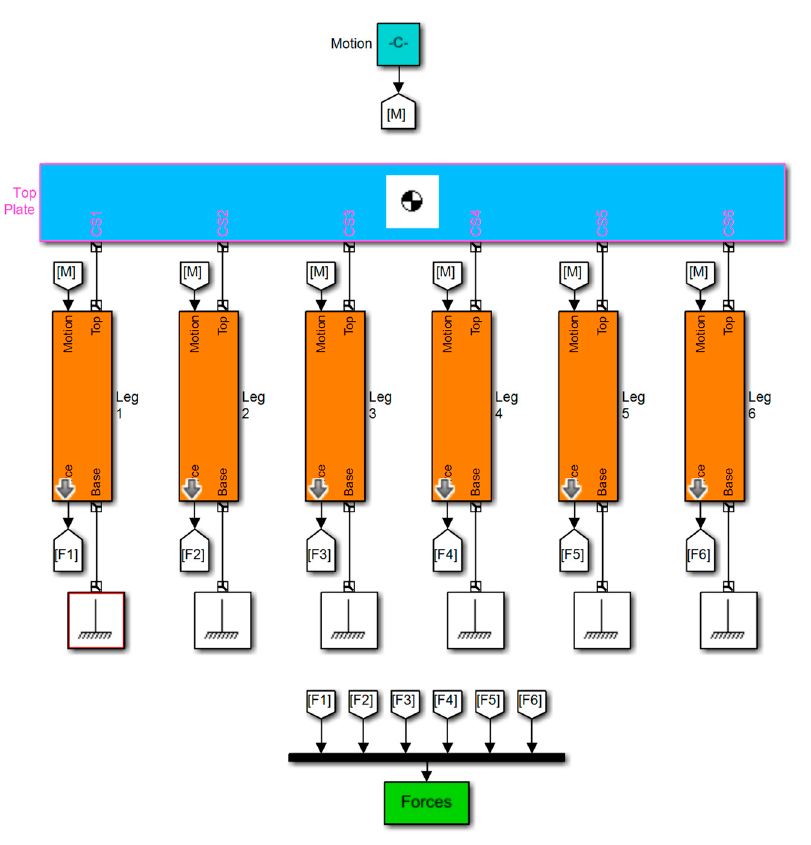
Figure 4. Simulink model of the Stewart platform.